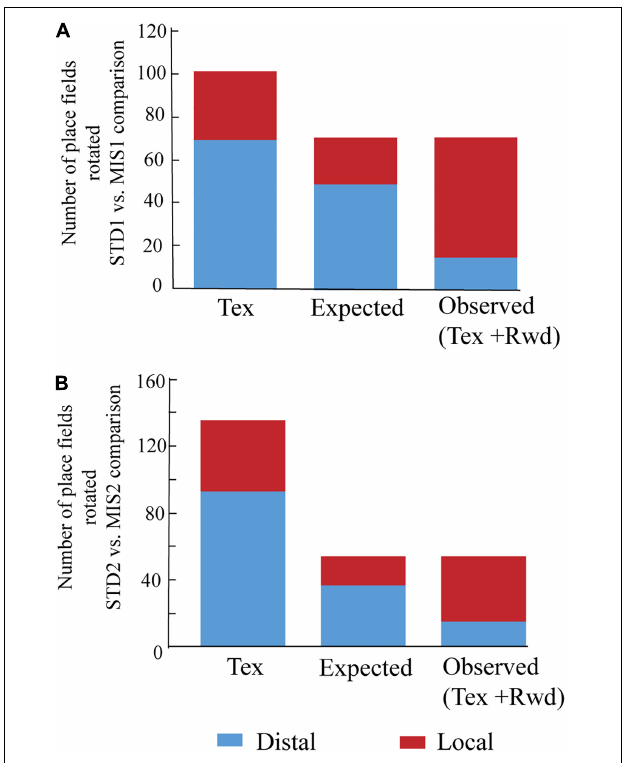
FIGURE 4 | Comparison of place field orientation in the Tex and Tex + Rwd paradigm. (A) The stacked histogram of the number of place fields rotated with distal and local cues in STD1 vs. MIS1 comparison in the Tex paradigm with the expected and observed number of place field rotations in the Tex + Rwd paradigm. The number of place fields oriented to distal and local cues in the Tex paradigm is 69 and 32. In the Tex + Rwd paradigm, the observed numbers are 15 (distal) and 56 (local). (B) The stacked histogram of the number of place fields rotated with distal and local cues in STD2 vs. MIS2 comparison in the Tex paradigm with the expected and observed number of place field rotations in the Tex + Rwd paradigm. The number of place fields oriented to distal and local cues in the Tex paradigm is 93 and 43. In the Tex + Rwd paradigm, the observed numbers are 15 (distal) and 39